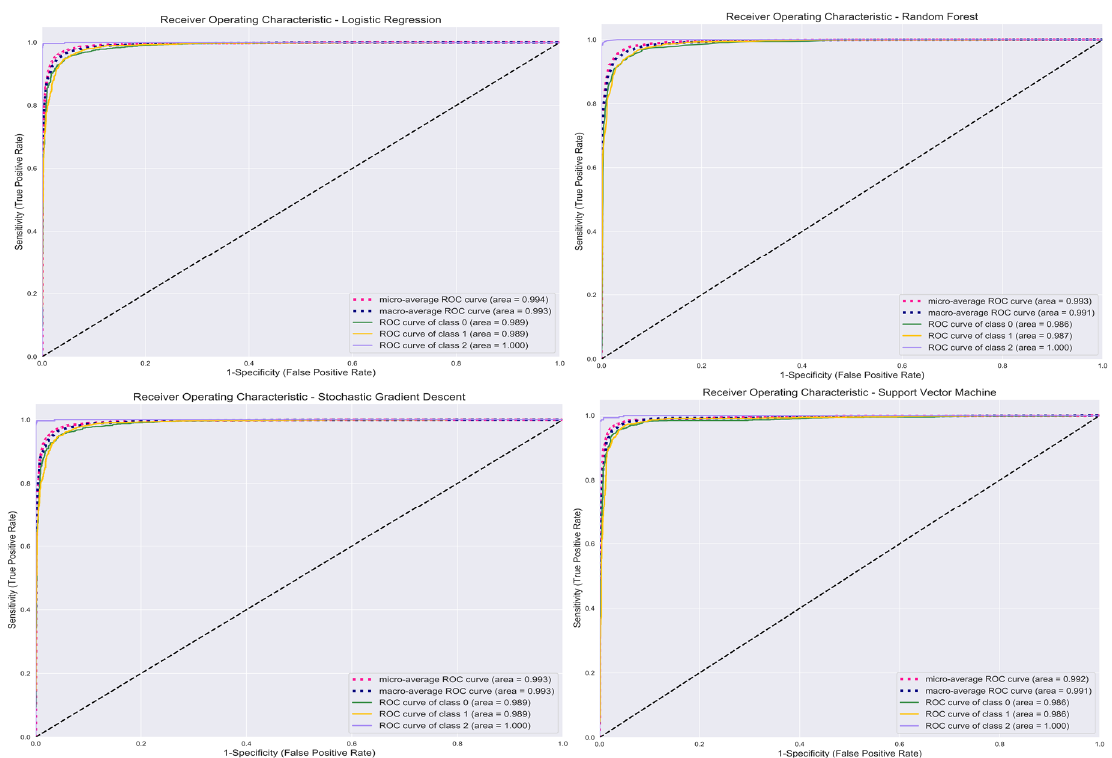
Figure 7. Performance evaluation using ROC for LR, RF, SGD, and SVM.